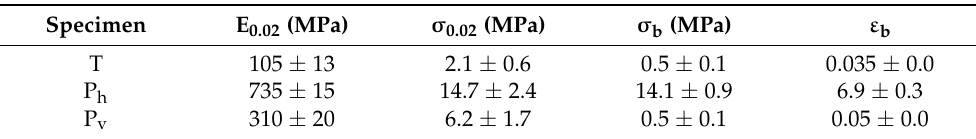
Figure 3. Stress-strain curve of a P h printed specimen after 1 cycle of load-unload experiment, highlighting the permanent deformation due to the elastic behavior of polymeric materials. This behavior is responsible for the stress-relaxation of polymers, and it is very important to be evaluated as it establishes the deformation over time that polymers suffer during their life cycle. From the previous tensile test results, it was clear that the initial load to be applied to each of the printed specimens for the stress-relaxation evaluation could not be the same, as the elastic deformation domain is different for each geometry and building orientation. Therefore, preliminary tests were conducted to evaluate the appropriate tension to apply to each type of printed specimen. From these tests, it was immediately clear that the P v geometry and building orientation did not satisfy the requirements in use, as the layers